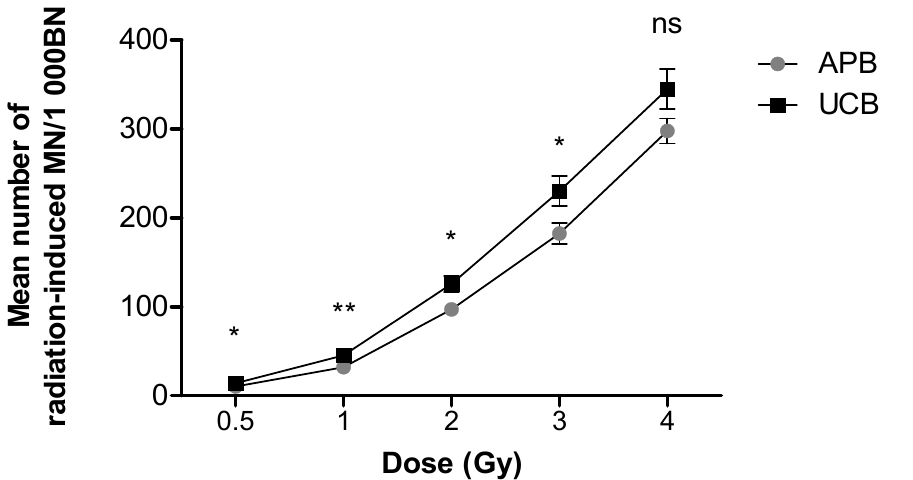
Figure 1. Dose–response curve of the mean number of MN in peripheral T-lymphocytes of adults ( n = 27) and newborns ( n = 32) induced by different doses (0.5, 1, 2, 3 and 4 Gy) of 60 Co γ -rays irradiation. The number of MN induced by the irradiation was obtained by subtracting the mean number of MN in the sham-irradiated controls (0 Gy) from the mean MN number scored in the irradiated samples. MN yields of UCB were significantly higher post-irradiation (0.5, 1, 2 and 3 Gy) compared to APB (** p < 0.01, * p < 0.05). However, after a 4 Gy dose, no significant (ns) difference was observed between APB and UCB ( p > 0.05). Error bars represent the standard error of the mean (SEM). At least 1000 BN cells were scored for each donor per condition.